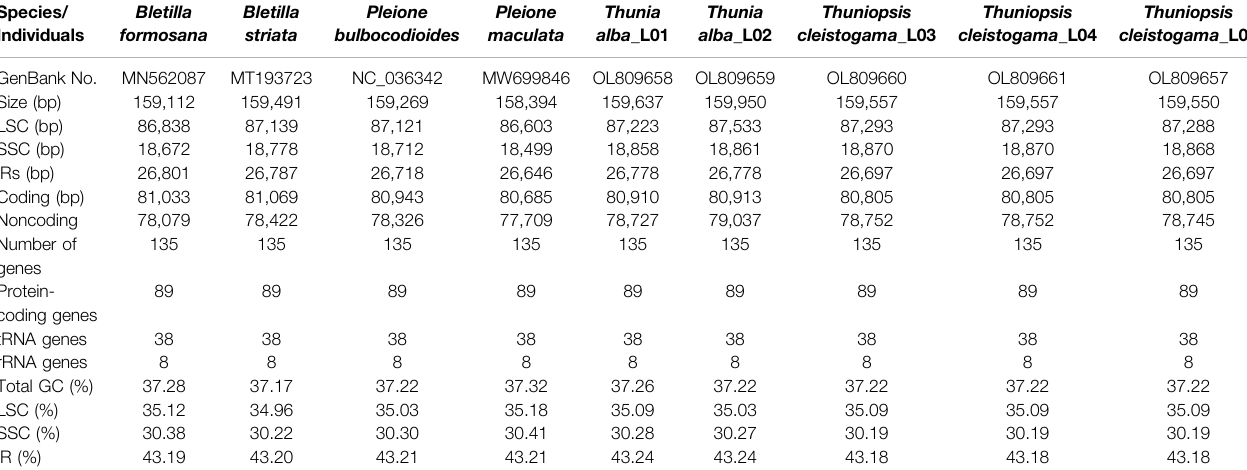
TABLE 1 | Characteristics of chloroplast genomes of Thuniopsis cleistogama and its related taxa. Species/ Individuals